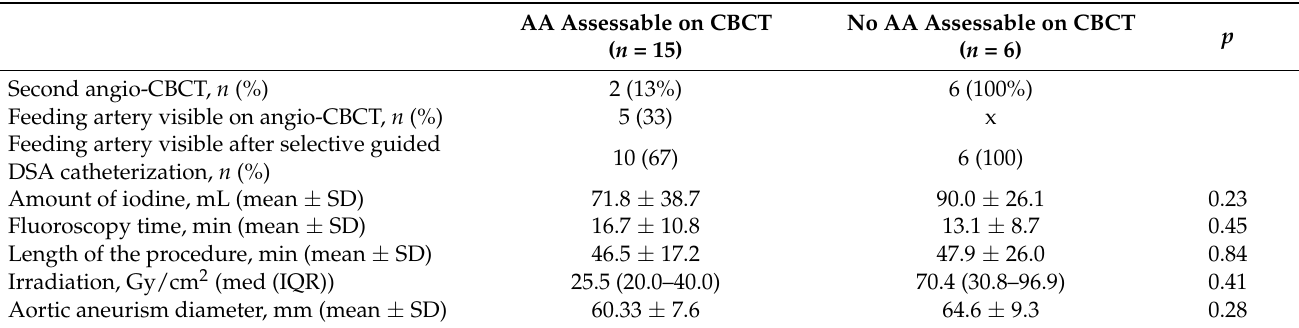
Table 2. Results of angiographies according to the visualization of the anterior spinal artery on the CBCT acquisition ( n = 21). AA: Adamkiewicz artery.